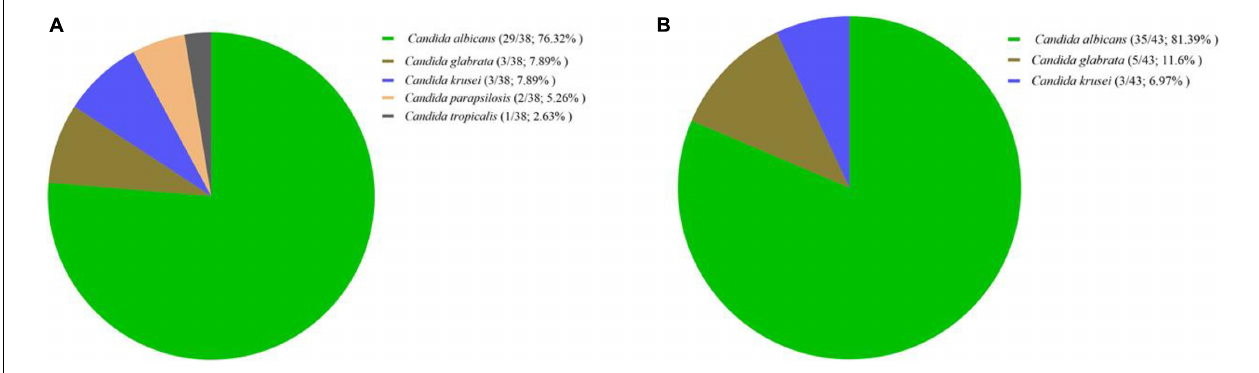
FIGURE 1 | Distribution of Candida species isolates recovered from patients with vulvovaginal candidiasis (A) and recurrent vulvovaginal candidiasis (B) . Prevalence was noted per number of patients in each arm. Further details on isolate number are listed in Table 1